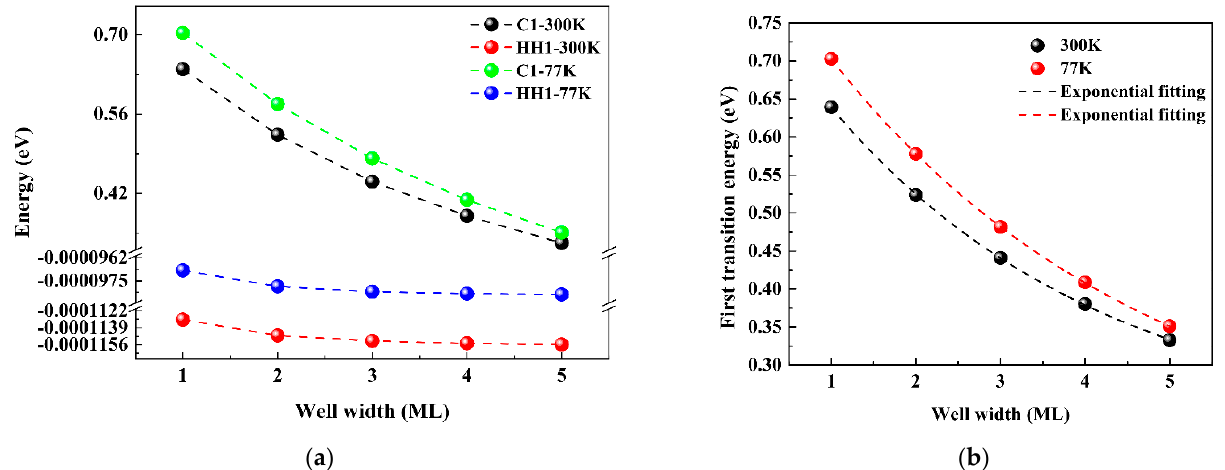
Figure 5. ( a ) Simulated electron (C1) and heavy − hole (HH1) confined energies and ( b ) first transition energies for InAs/GaSb multi-quantum-wells for 1 up to 5 MLs of InAs and 50 nm barrier (GaSb) width.